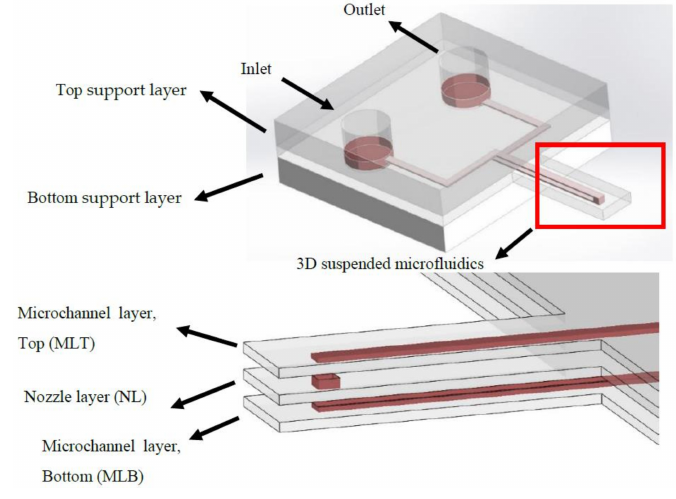
Figure 1. Three layers of the suspended microfluidics. Table 1. Parameters used for suspended microfluidics simulation [25], where L denotes length, W denotes width, and T denotes thickness.